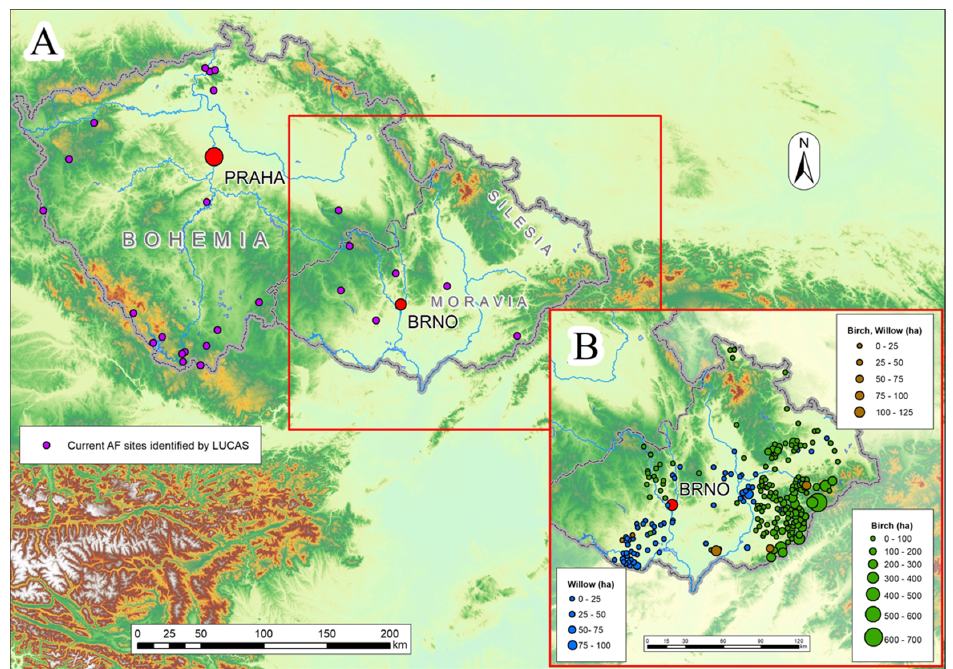
Figure 1. Agroforestry sites in the Czech Republic identified by LUCAS and confirmed by LPIS, orthophoto maps or personal visit ( A ), and pastures with trees in the 19th century in Moravia and Czech Silesia ( B ). Dominant tree species as well as the size of the pastures are indicated.